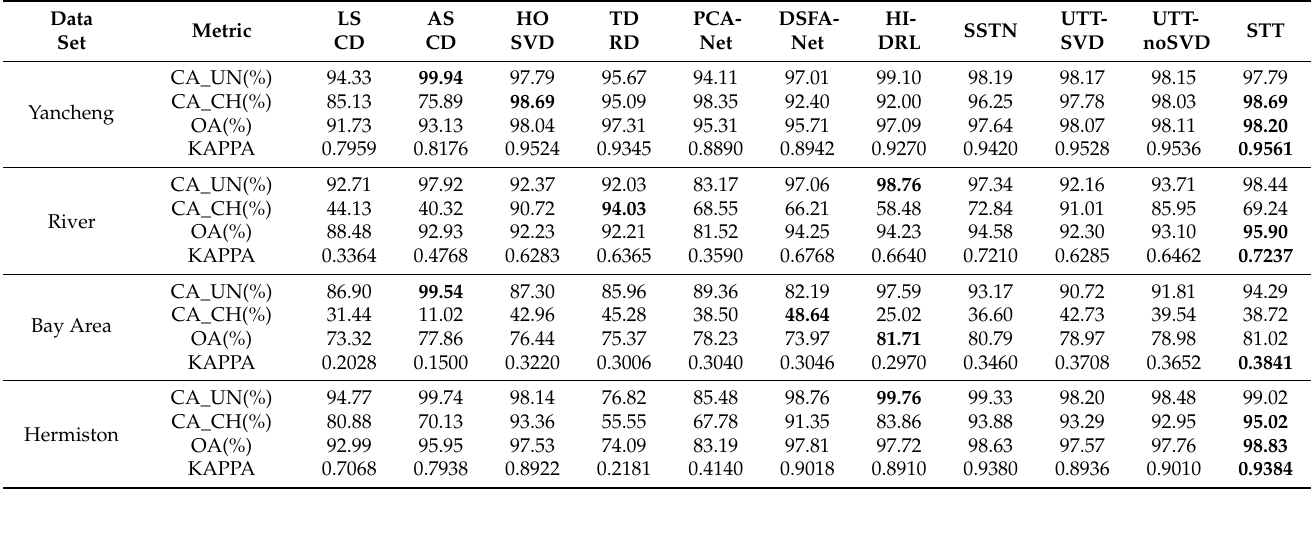
Table 1. Evaluation of change detection results in different datasets.